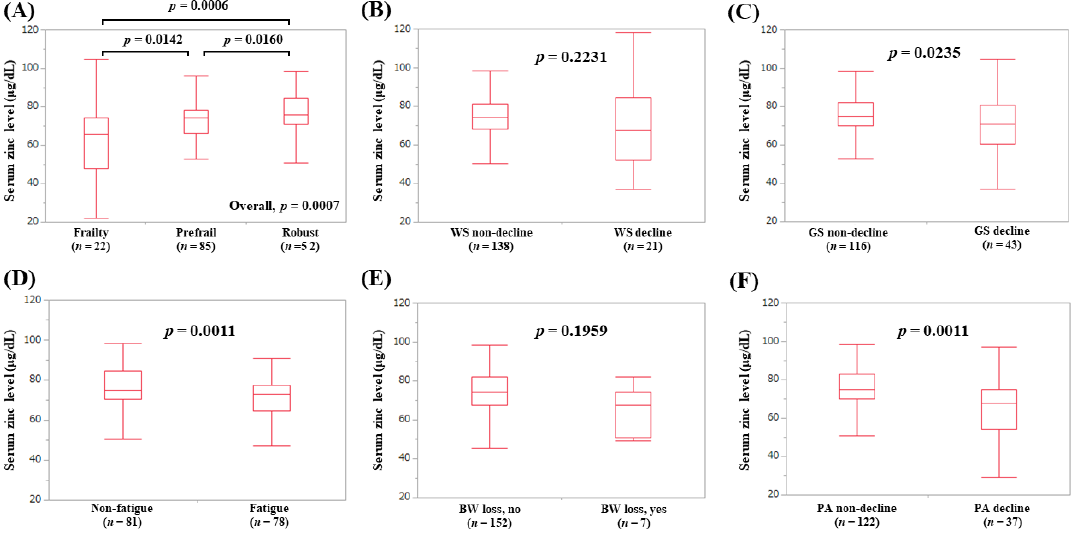
Figure 9. Serum Zn level according to the frailty status ( A ) and serum Zn level according to each phenotype in female patients: ( B ) walking speed, ( C ) grip strength, ( D ) fatigue, ( E ) body weight